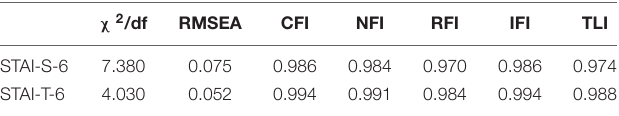
respondents was 18–25 years ( n = 37), 26–30 years ( n = 1), and 41–50 years ( n = 2).